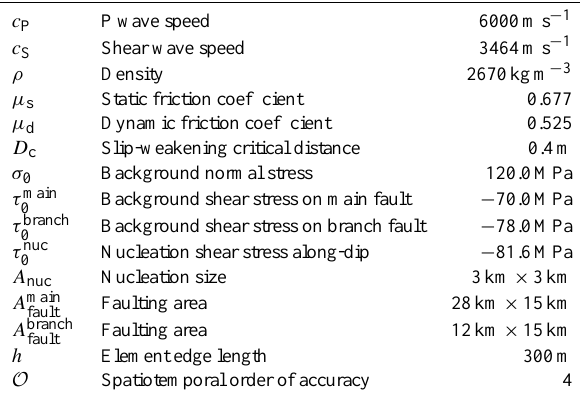
Table 3. Simulation parameters for SCEC test case